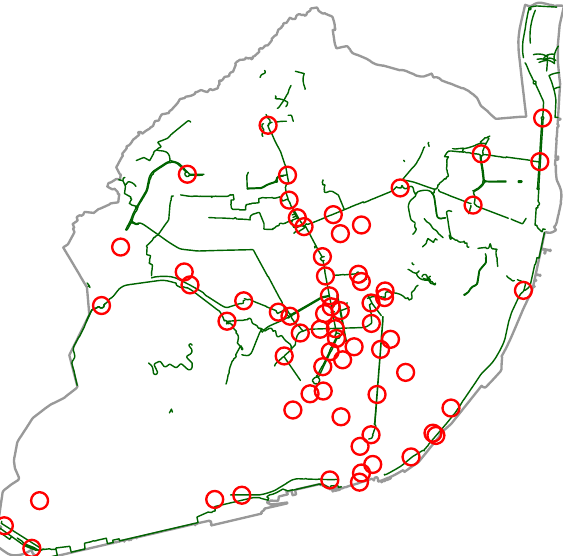
Figure 1. Cycling infrastructure in Lisbon as October 2021 and location of cyclists’